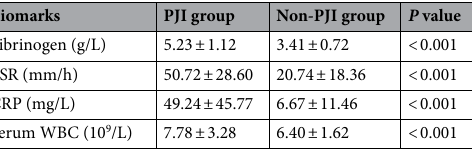
Table 3. The traditional biomarkers and plasma fibrinogen between PJI group and non-PJI group.